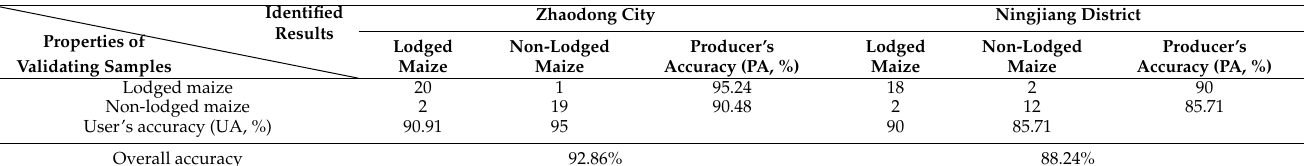
Figure 7. Distribution maps of the lodged and non-lodged maize in ( a ) Zhaodong City and ( b ) Ningjiang District. Table 3. Error matrix between the identified results of the lodged and non-lodged maize and the properties of validating